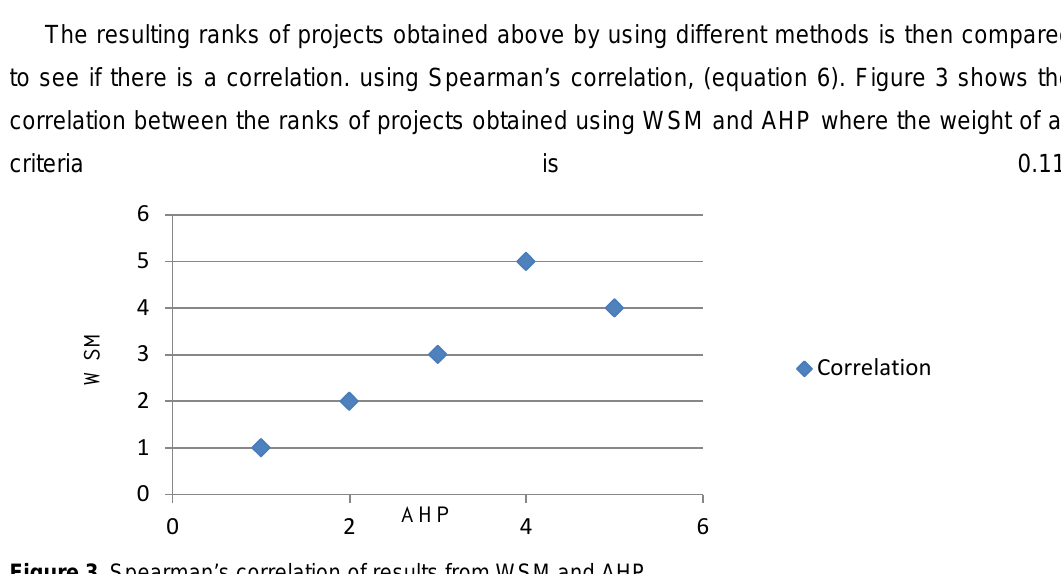
Figure 3 . Spearman’s correlation of results from WSM and AHP.